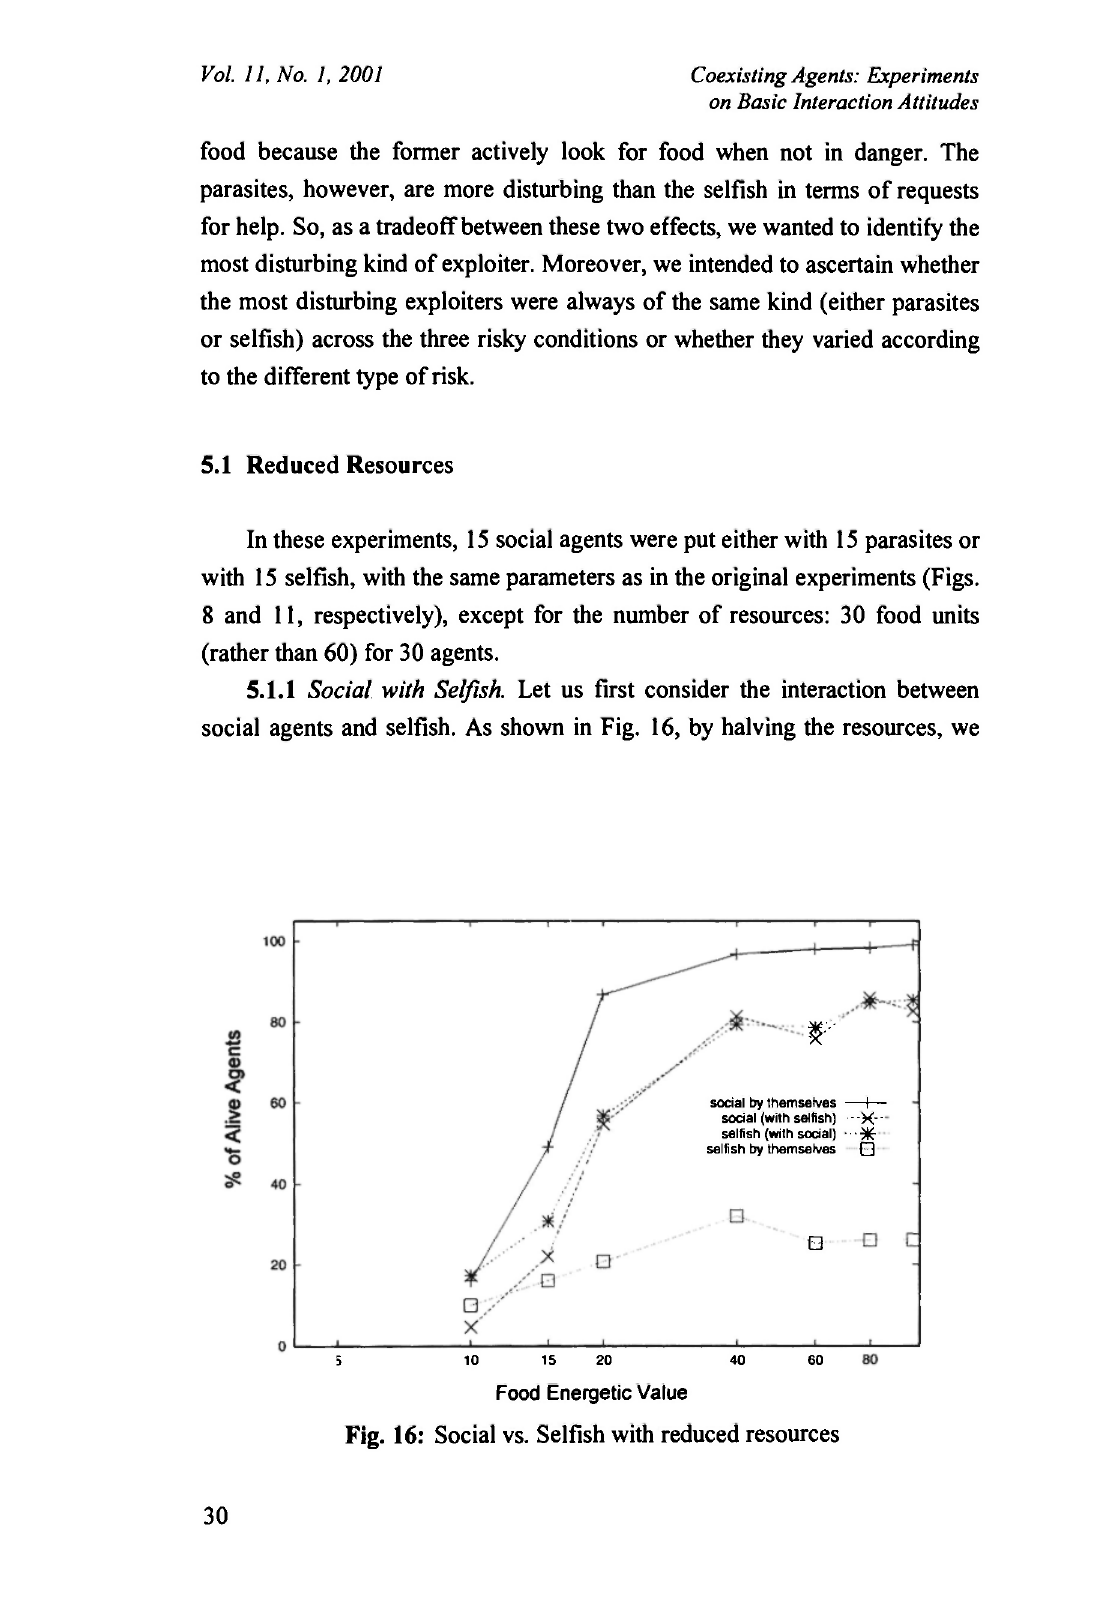
Fig. 16: Social vs. Selfish with reduced